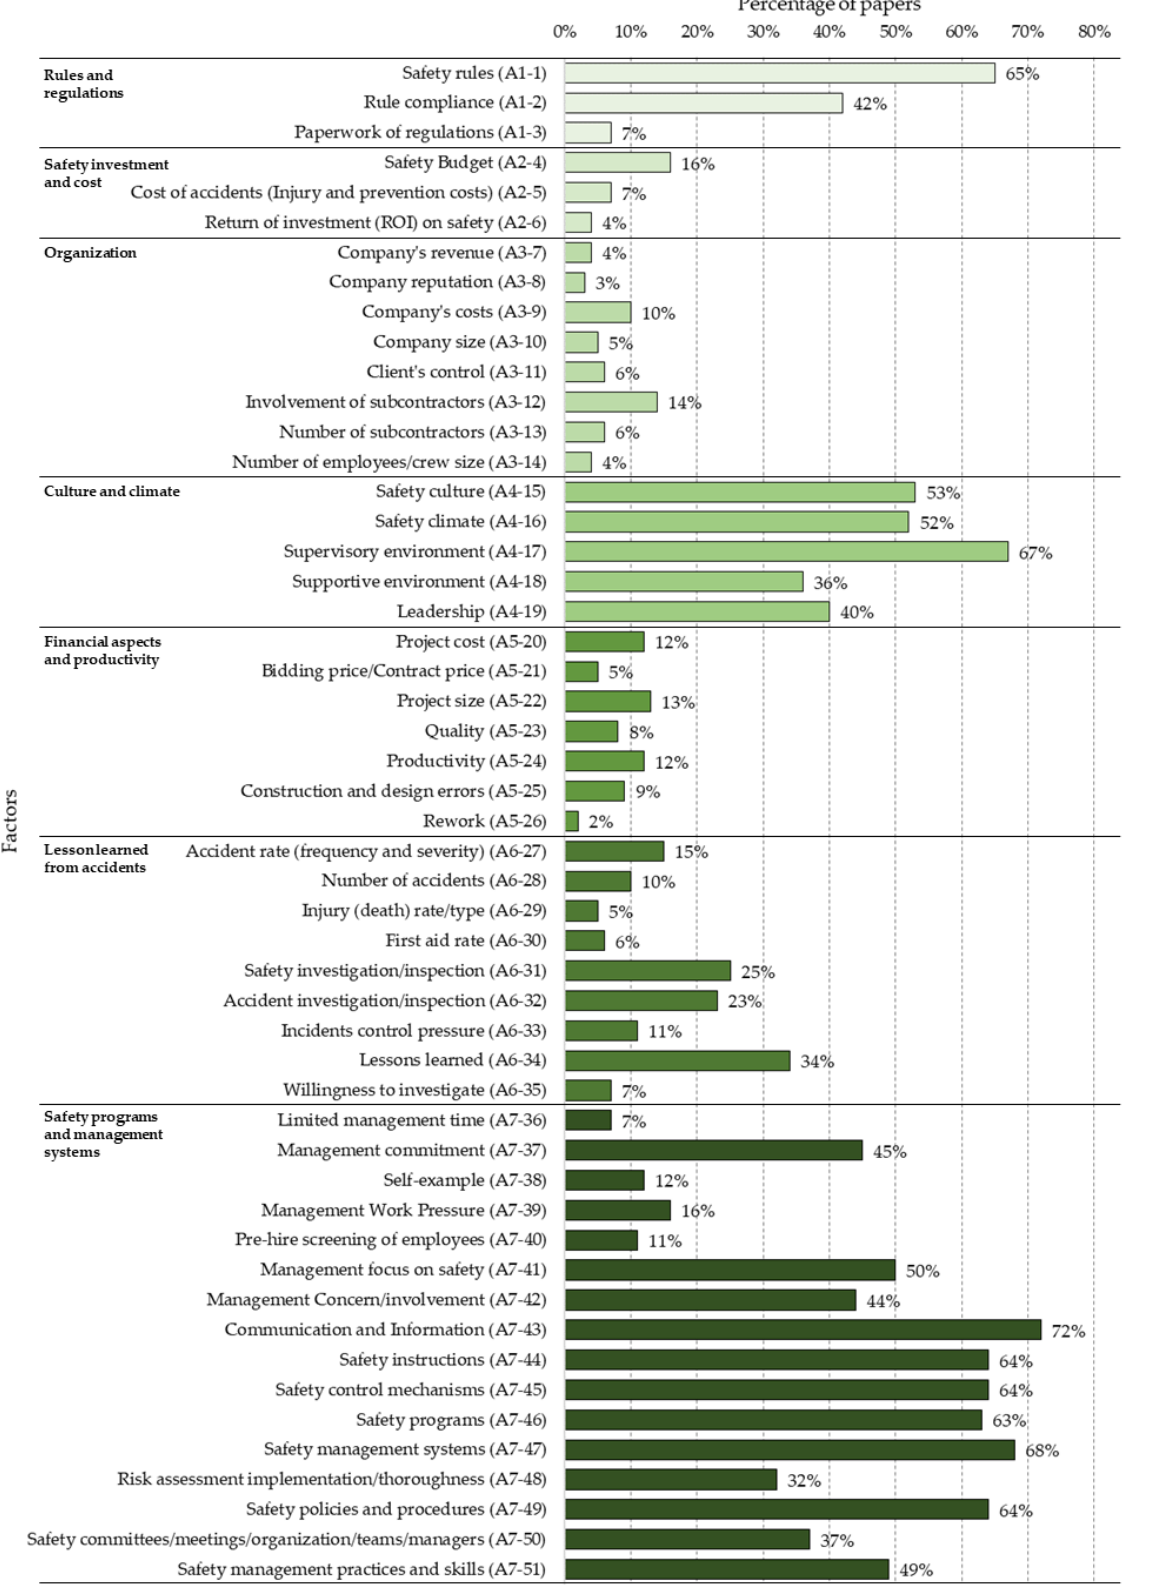
Figure 7. Percentage distribution of factors in the “General aspects (A)” category.